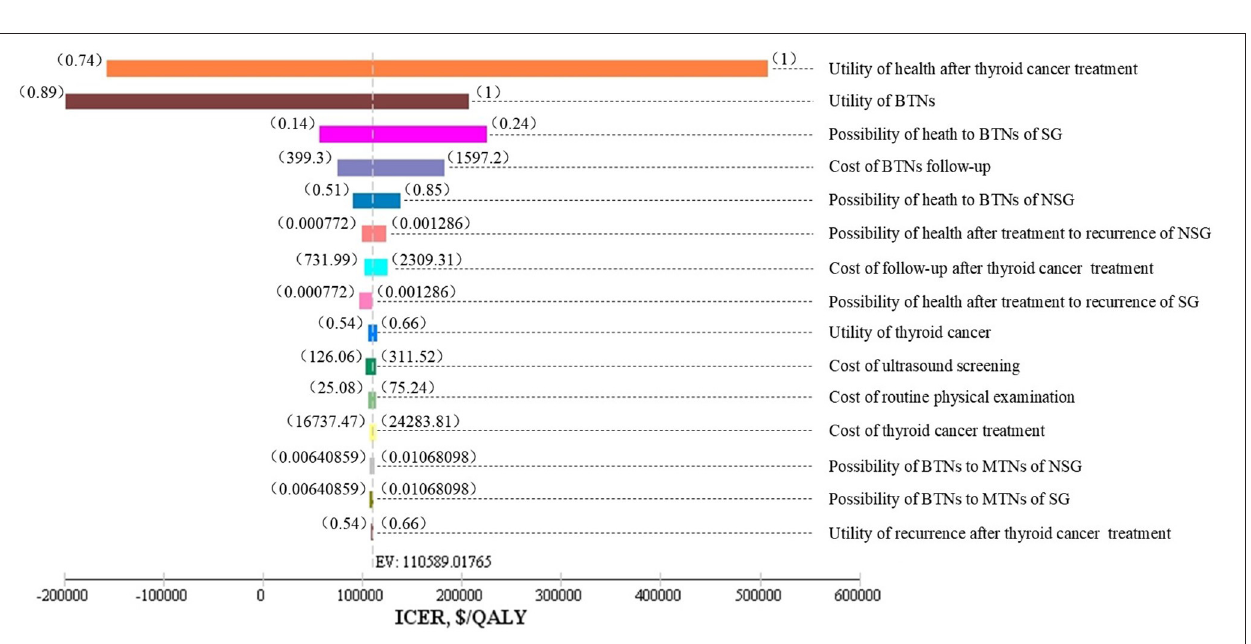
FIGURE 2 | Tornado diagram. SG, screening group; NSG, non-screening group; BTNs, benign thyroid nodules (state); MTNs, malignant thyroid nodules (state); EV, expected